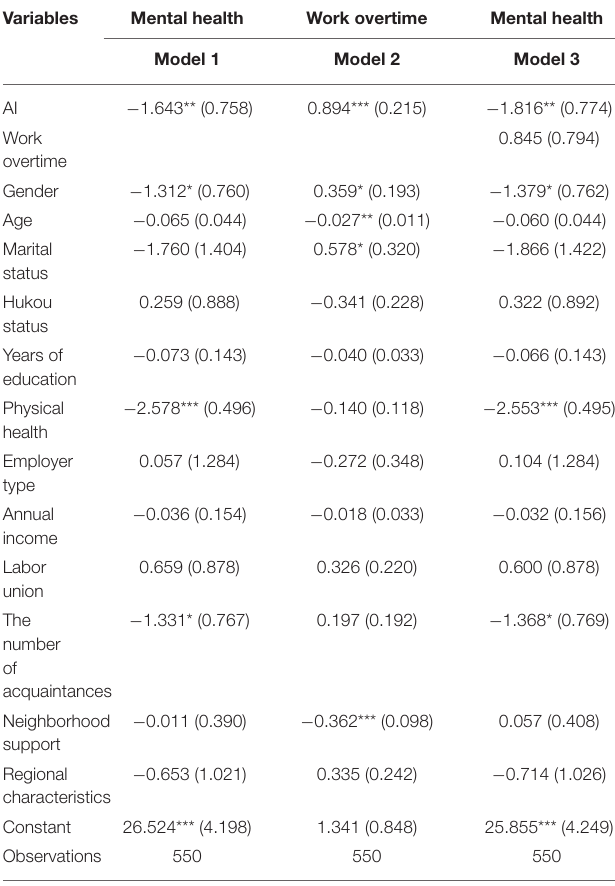
TABLE 2 | The impact of AI on the mental health of manufacturing workers: overall and mediating